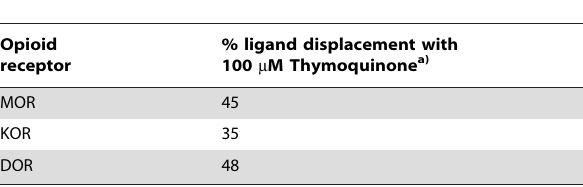
Table 1. In vitro ligand displacement by thymoquinone.